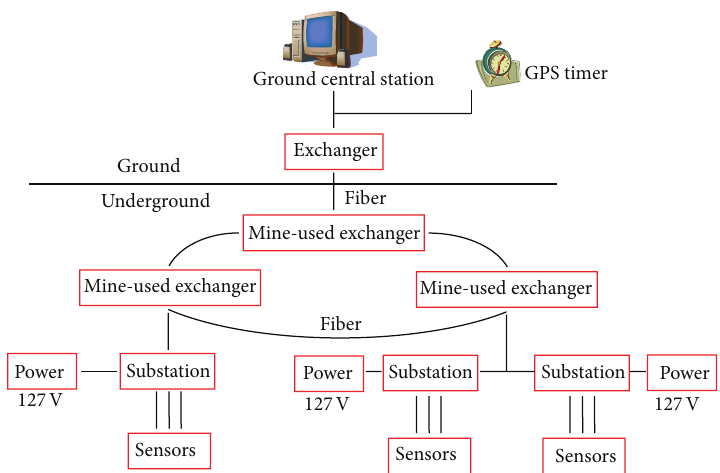
Figure 5: Example waveforms of a microseismic event recorded in artificial blasting test.